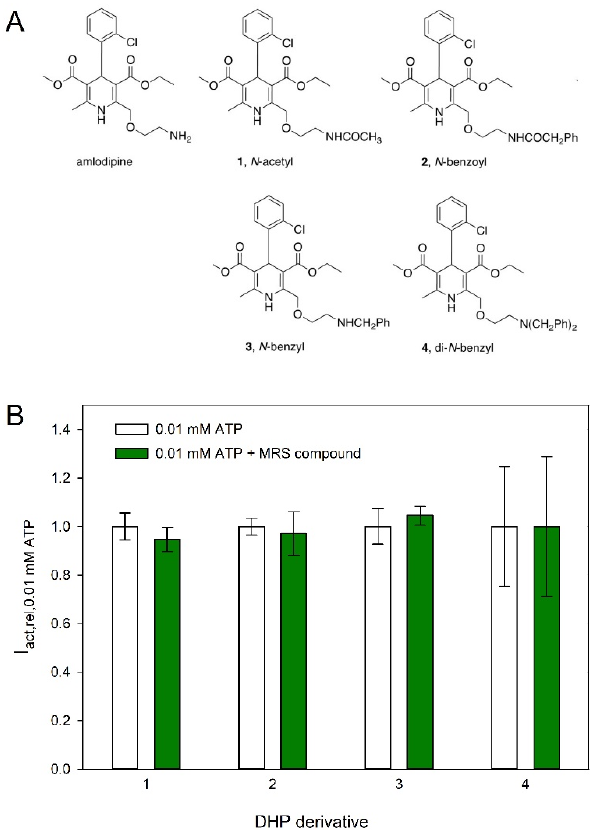
Figure 7. Effects of amlodipine-derived compounds on hP2X5 FL -mediated currents. ( A ) Structures of amlodipine and four newly synthesized DHPs derived from amlodipine. ( B ) Statistics of the effect of the MRS compounds shown in A. Means are from of 7–9 oocytes.